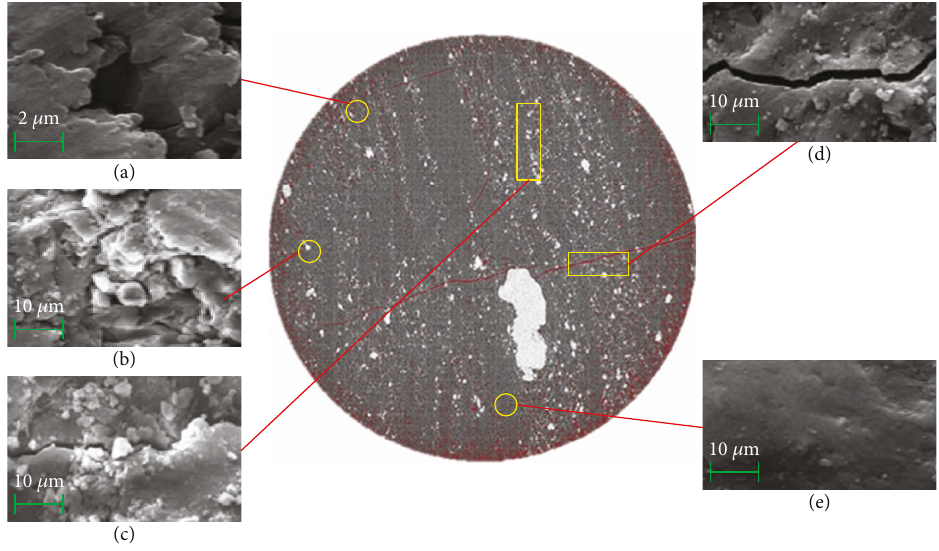
Figure 4: CT images and SEM images of coal in di ff erent